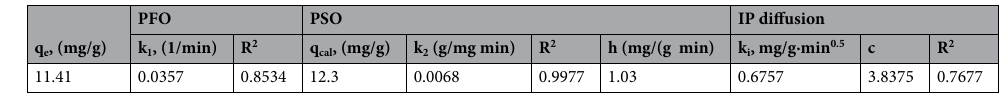
Table 2. Kinetics parameters for CR dye adsorption on